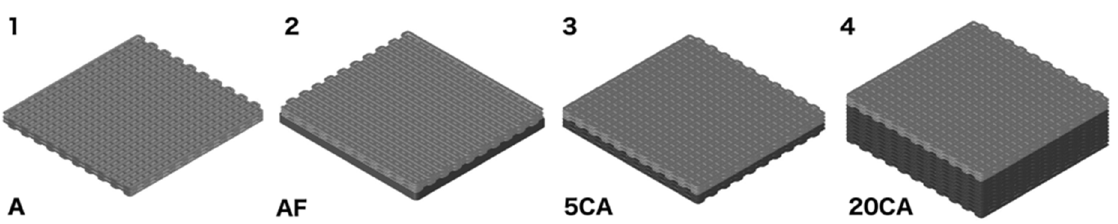
Figure 1. Schematic representation of 3D constructs. Light grey represents SSD-loaded alginate hydrogels, and dark grey represents chitosan hydrogels: ( 1 ) 3D printed 5-layer alginate loaded with SSD alone (A); ( 2 ) 3D printed 5-layer alginate + chitosan film (AF) ( 3 ) 3D printed 5-layer chitosan hydrogel + 3D printed 5-layer alginate (5CA); ( 4 ) 3D printed 20-layer chitosan hydrogel + 3D printed 5-layer alginate (20CA).